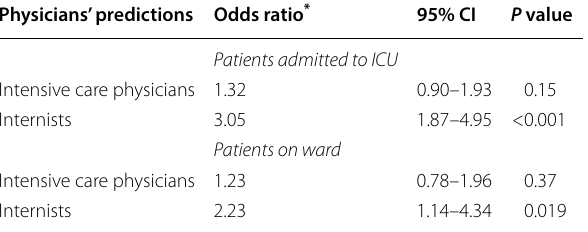
Table 5 Multivariate regression model of